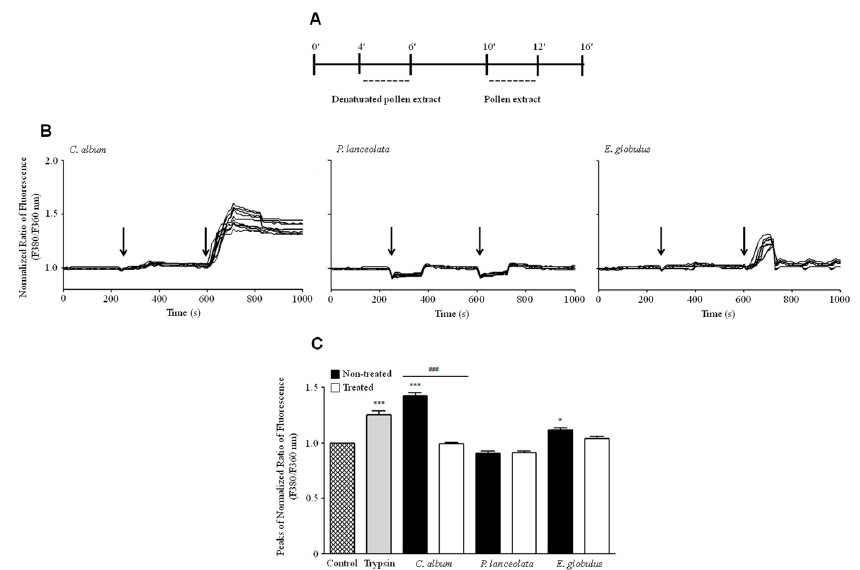
Figure 4. Functional characterization of the effect of pollen proteases from Chenopodium album (0.26 ± 0.06 mg/ml), Plantago lanceolata (0.18 ± 0.03 mg/ml) and Eucalyptus globulus (0.75 ± 0.18 mg/ml) on Calu-3 cells. (A) Calu-3 cultures were incubated for 240 s with Krebs solution and stimulated for 120 s with denatured pollen diffusates followed by 120 s incubation with pollen diffusates. (B) [Ca2+] i variations in Calu-3 cells after exposure to C. album (left graph), P. lanceolata (middle graph) and E. globulus (right graph). Arrows in each panel indicate the time of addition of the pollen diffusate. The fluorescence profiles are representative of 10 cells. (C) The bar graph shows the maximal changes in [Ca 2+ ] i after stimulation with each pollen diffusate. Changes in [Ca 2+ ] i are depicted by the F 340 /F 380 fluorescence ratios of Fura-2-loaded Calu-3 cells. The black bars correspond to each pollen diffusate, while the white bars correspond to denatured pollen diffusates (95 °C for 30 min). The positive control for this assay was a 0.25% trypsin solution. The data are expressed as the mean ±SEM values of at least 30 representative cell traces using Bonferroni’s post-test: *** p < 0.001; * p < 0.05 ( n = 4 ) in comparison to the control condition and for comparisons between treated and untreated conditions ### p < 0.001 ( n = 4 ).